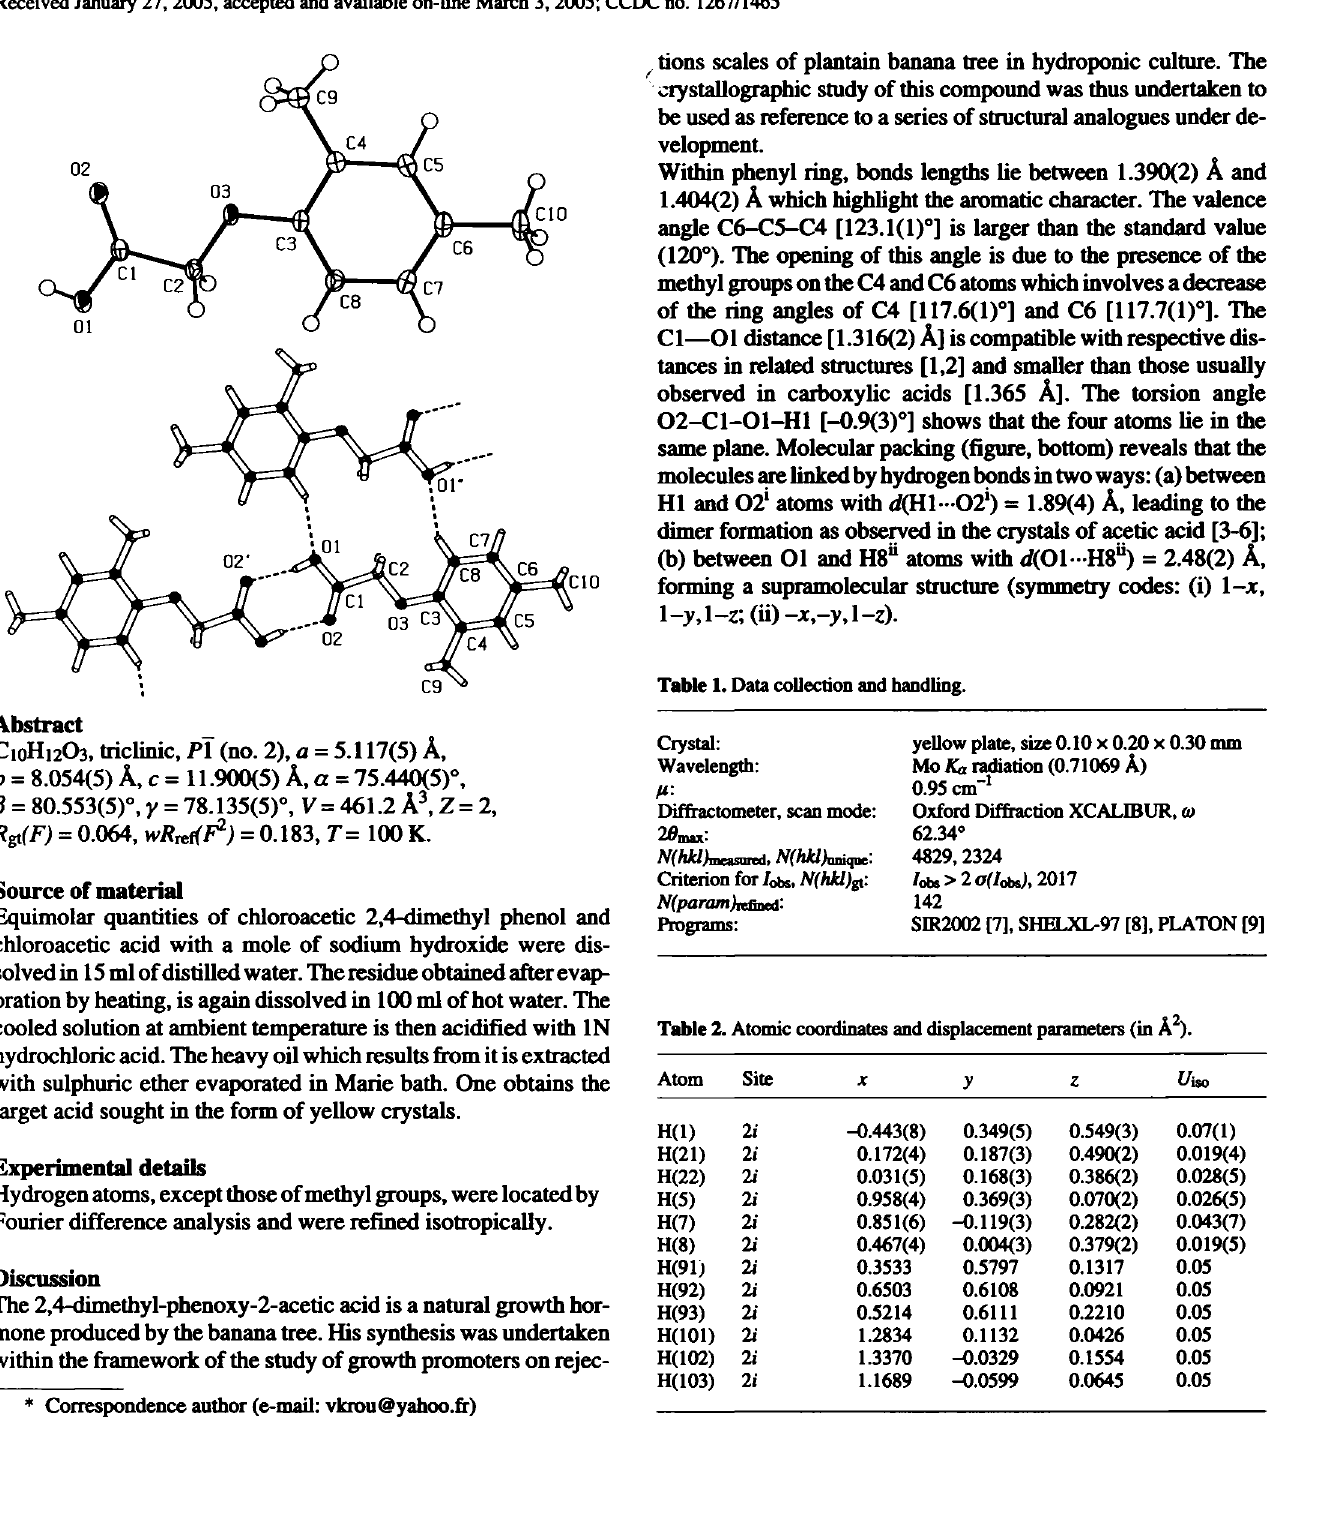
Table 2. Atomic coordinates and displacement parameters (in Ä 2